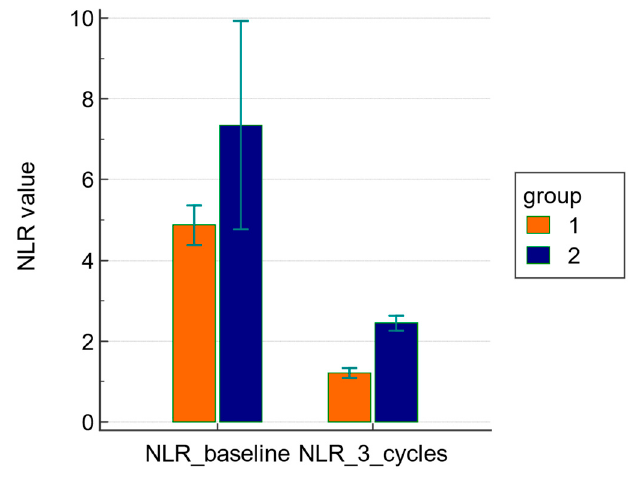
Figure 1. ANOVA for repeated measures showed a significant difference of the mean changes of NLR at baseline and after three cycles of NACT. NLR at baseline and after three cycles of NACT.